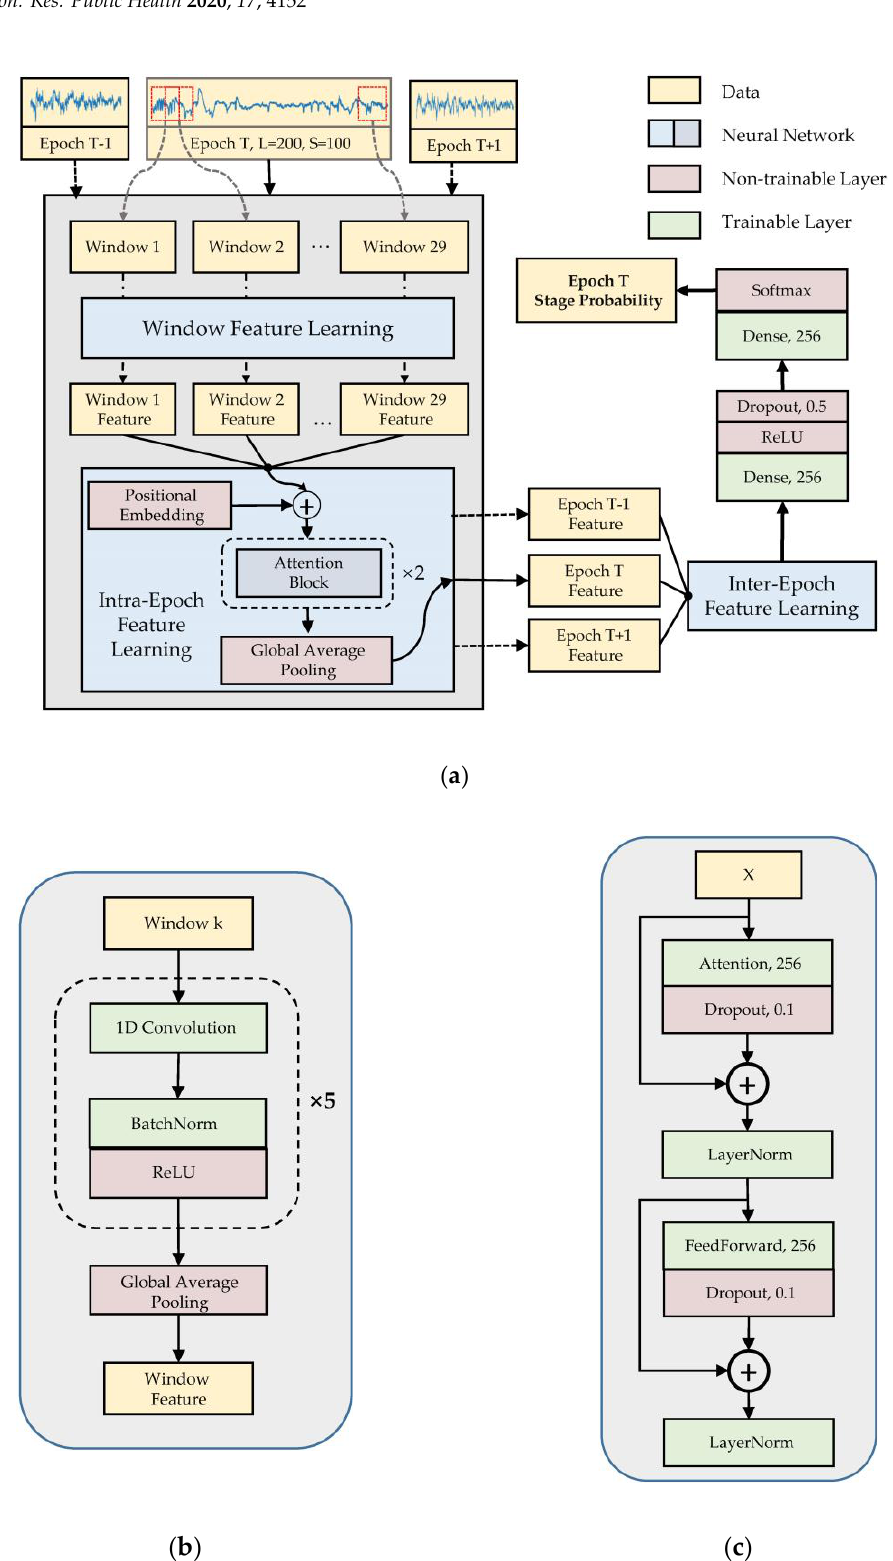
Figure 4. Model architecture: ( a ) whole model; ( b ) window feature learning; ( c ) attention block.